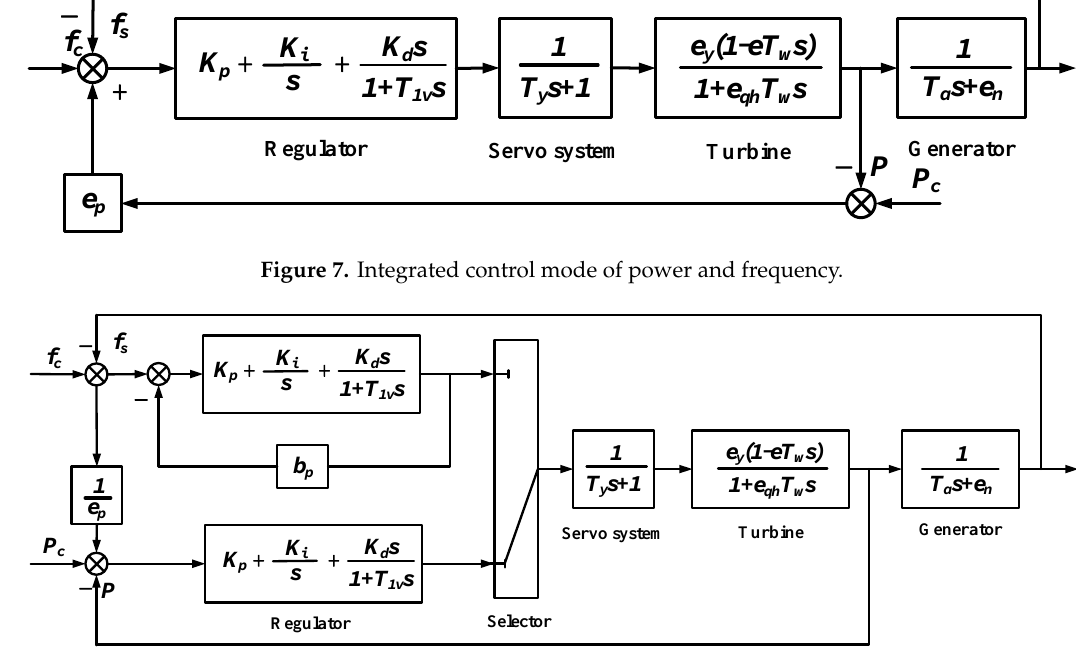
Figure 8. Selective control mode of frequency and power.